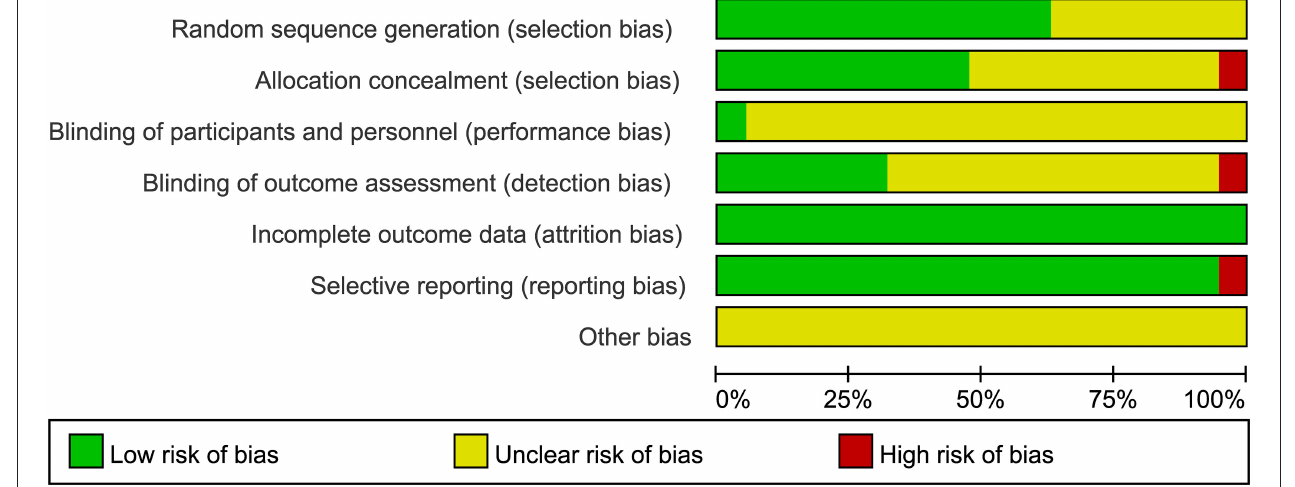
FIGURE 2 | Judgments about each risk of bias item presented as percentages across all included studies.